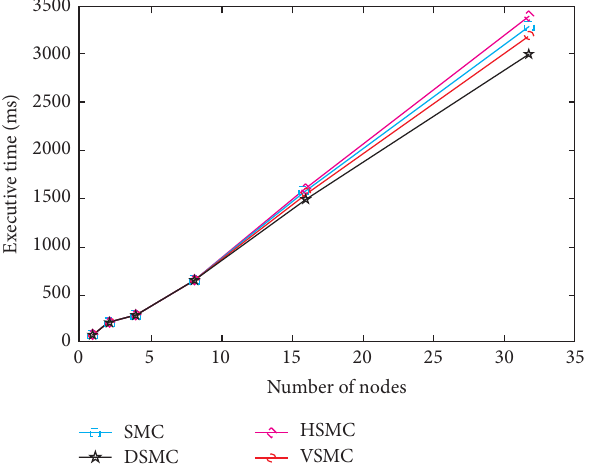
Figure 5: Comparison of cluster architecture.